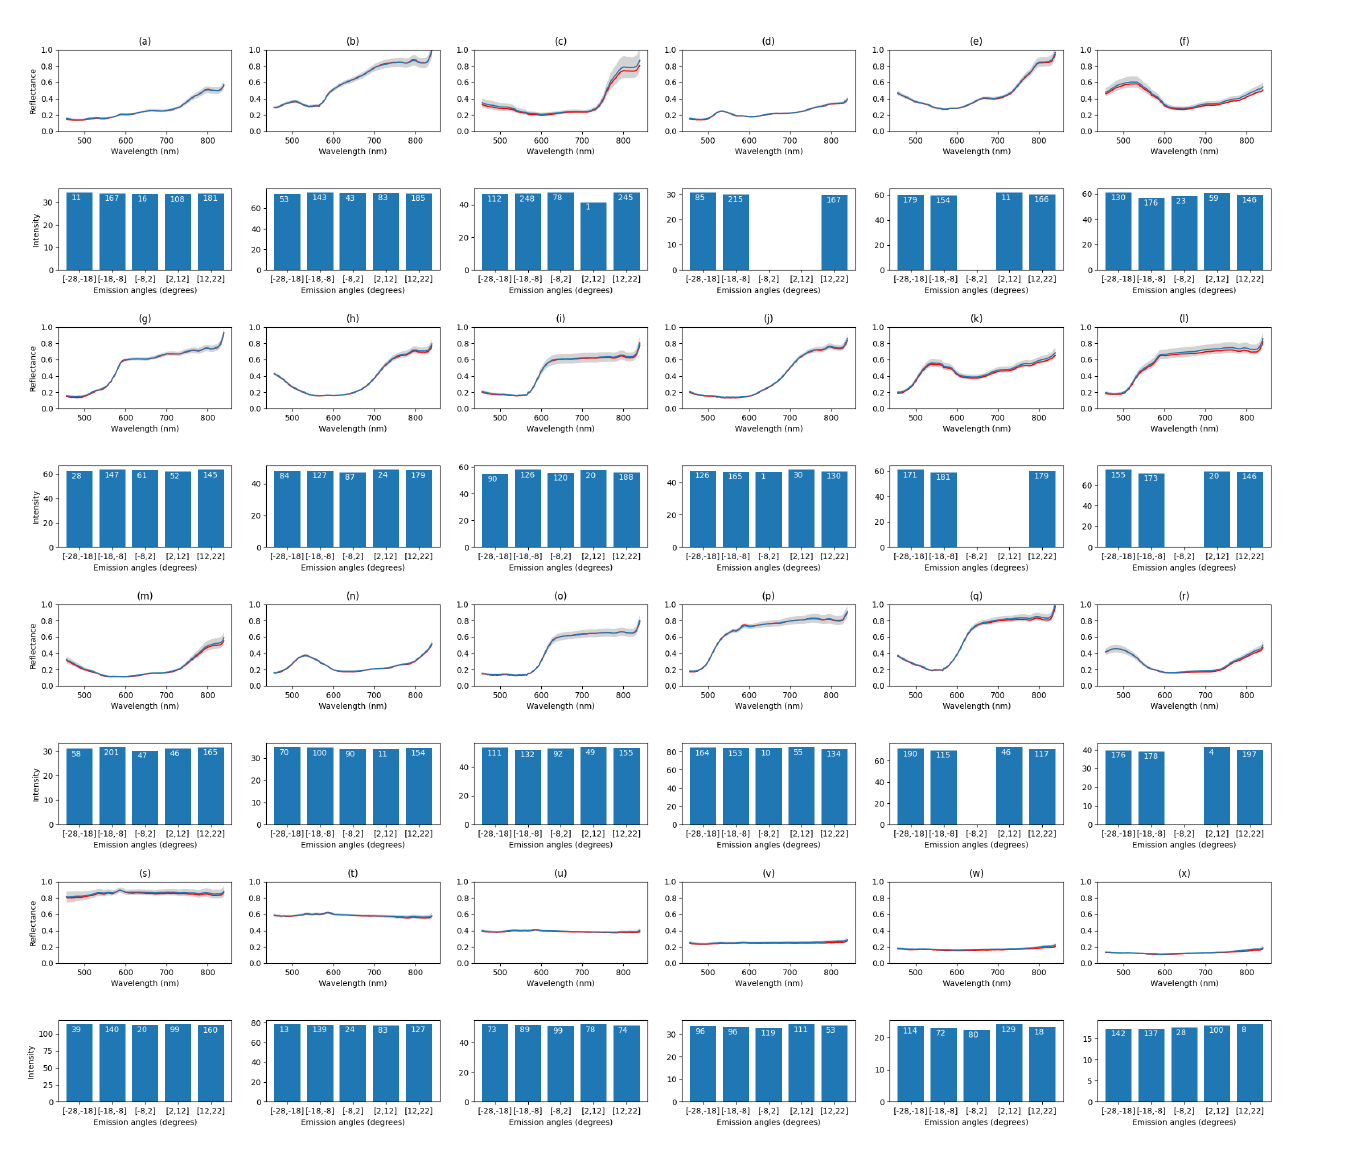
Figure 11. The average spectra and the intensity histograms of each matching color tile ( a – x ) of the reference color checker in Figure 12. The average spectra of all measurements are plotted on top in blue, the front view average spectrum is plotted in red and the intensity histograms, the band-wise sum of the reflectances, per emission angle are on the bottom. The sample count per a histogram bin is displayed in white. The gray color in the top plots illustrate the band-wise standard